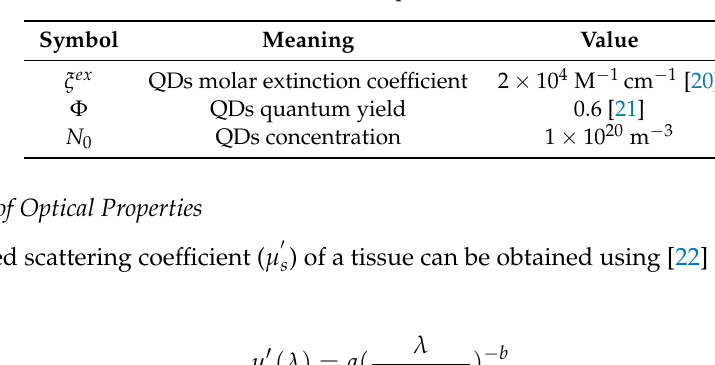
Table 1. Parameters of quantum dots